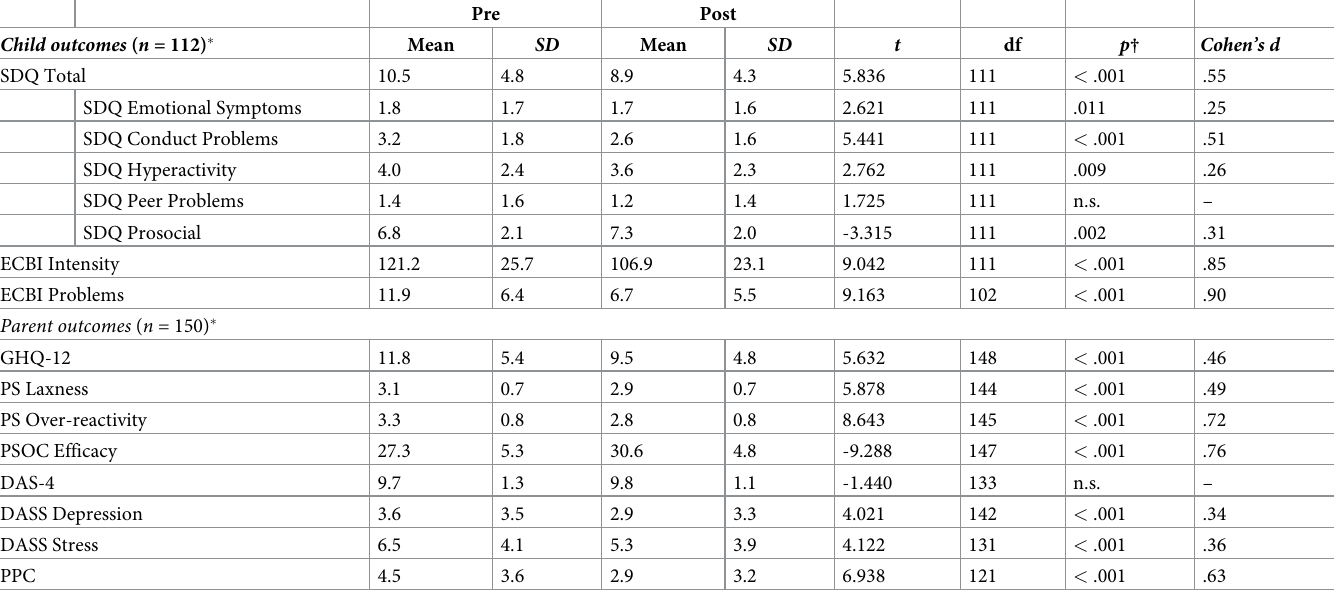
Table 2. T-tests for Triple P group pre–post